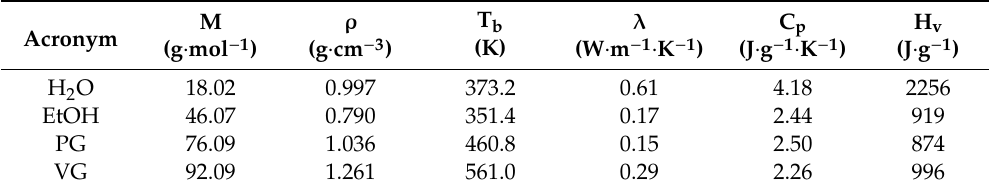
Table 2. Properties of the studied liquids given at ambient temperature (Design Institute for Physical Properties (DIPPR) database: https: // www.aiche.org /